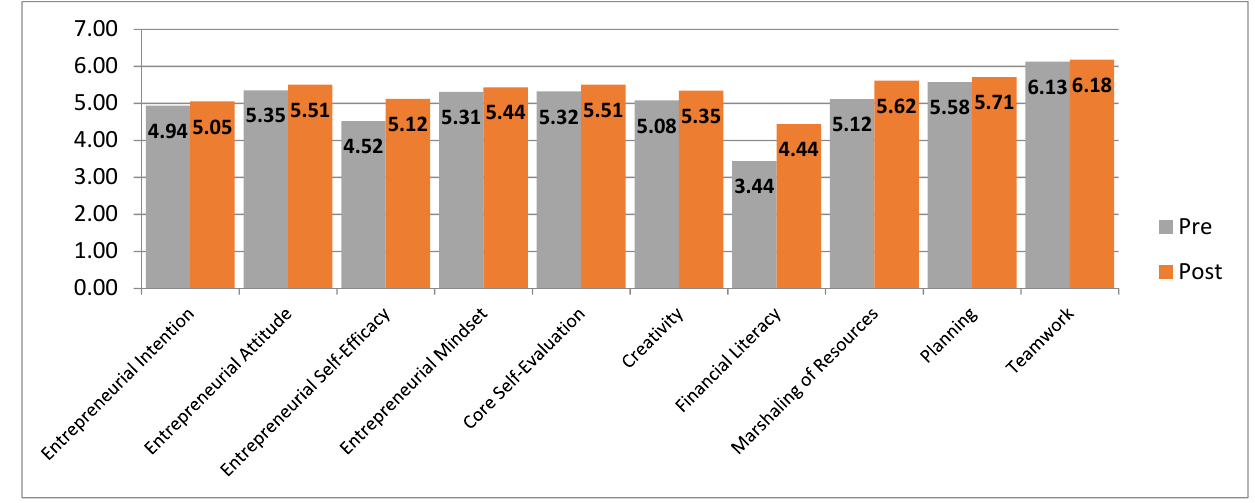
Figure 2. The average values of the entrepreneurial characteristics, pre- and post-course, of the female students.